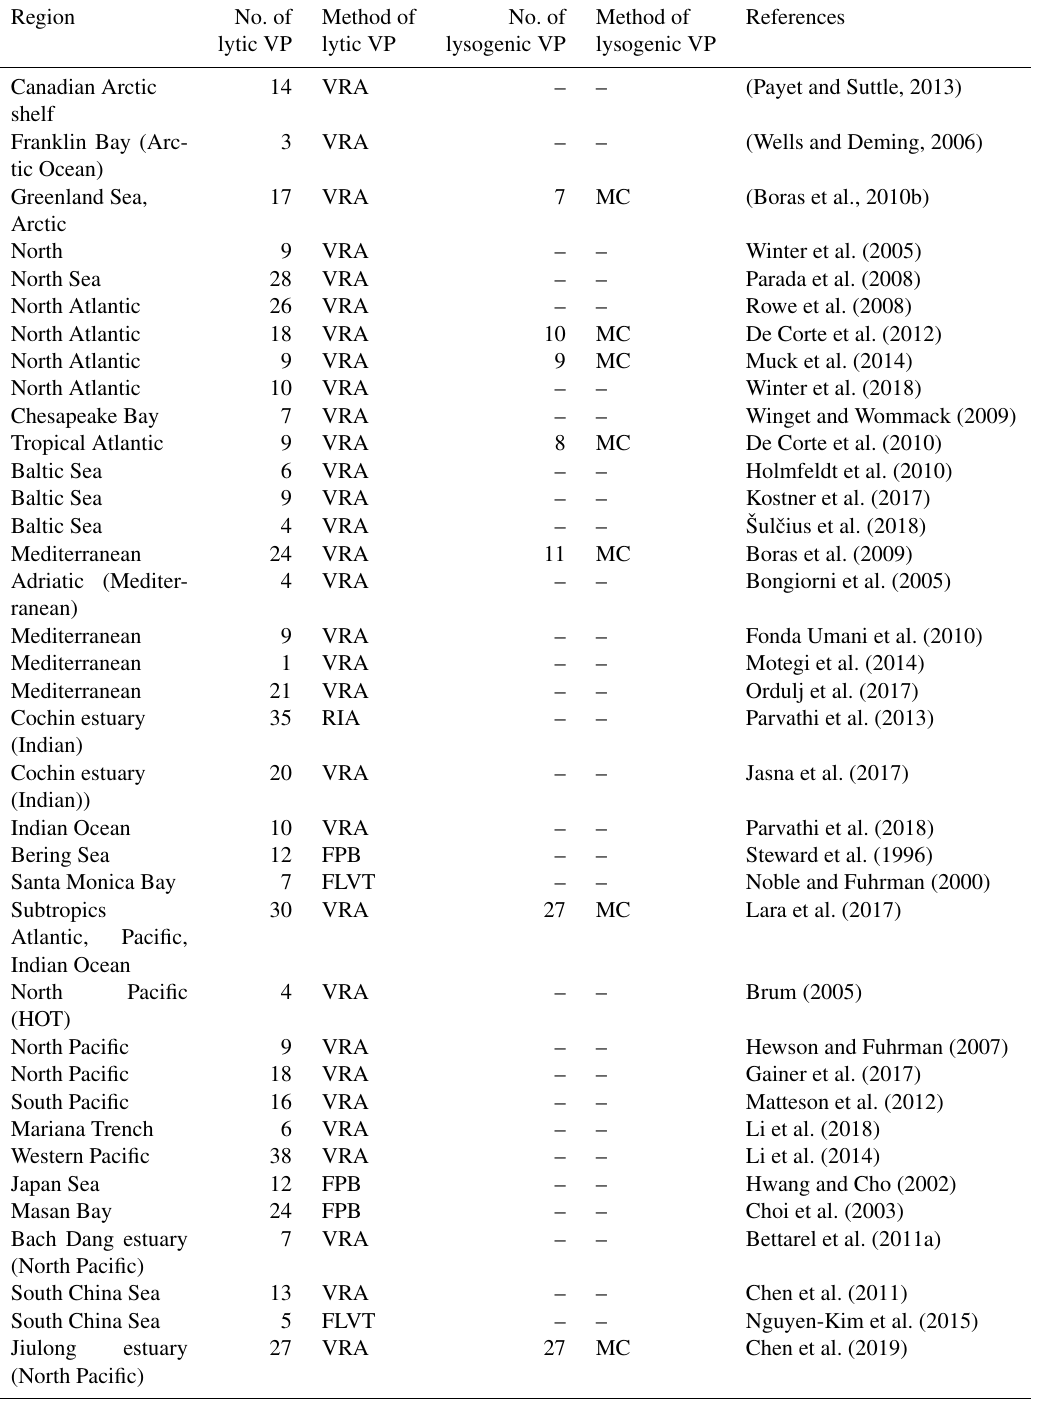
Table A2. Sources and methods of VP data. FPB: calculated by multiplying the fraction of viral infected cells, prokaryotic production and burst size; RIA: radioactive incorporation approach; FLVT: fluorescently labeled viral tracers method; VRA: virus reduction approach (see main text Sect. 2.3 for details). MC: virus reduction approach with addition of inducing agent such as mitomycin C (see main text Sect. 2.4 for